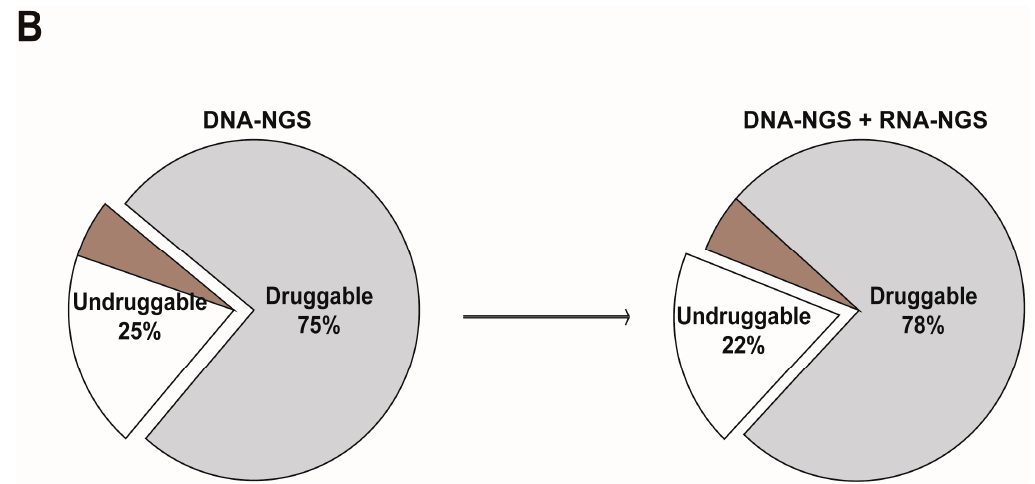
Figure 3. The comparison of fusion detection rates between DNA and RNA sequencing. ( A ) RNA se- quencing increased the detection proportion of total and druggable fusions; and ( B ) RNA sequencing expanded the scope (enlarged the proportion) of druggable patients in